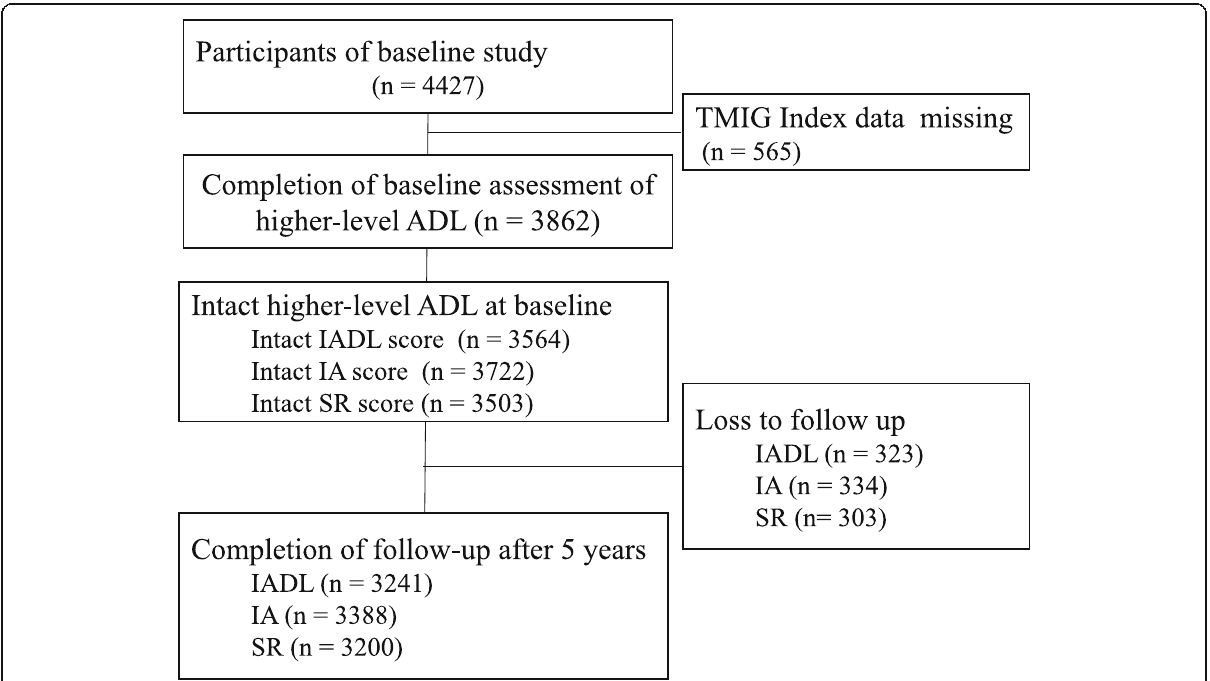
Fig. 1 Flow of participants. IADL, instrumental activities of daily living; IA, intellectual activity; SR, social